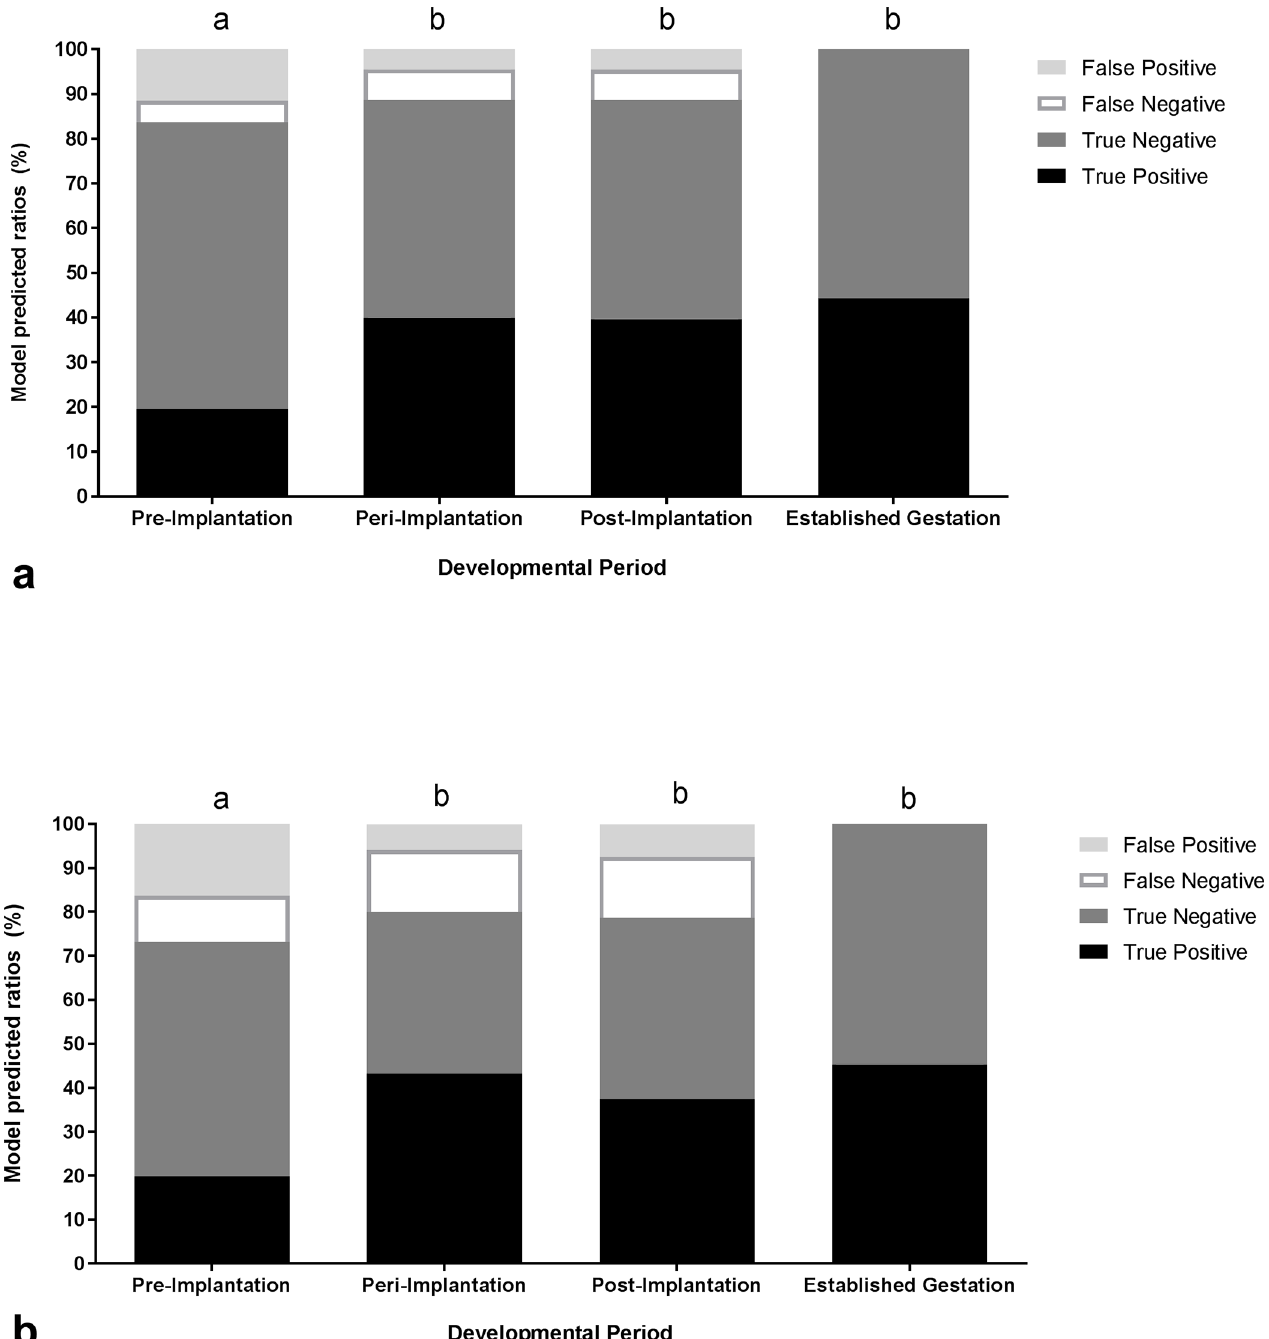
Fig 3. Predicted ratios of each category; true positive (black segment), true negative (dark grey segment), false negative(white segment) and false positive (light grey segment), generatedfrom an Ordinal Logistic Regression for the accuracy of using TRUS to detect pregnancy(a) and multiples per ewe (b) duringpre-implantation (day 12/14), peri-implantation (day 17/19), post-implantation (day 28) in reference to results obtained by TCUS duringestablished gestation(day 54).